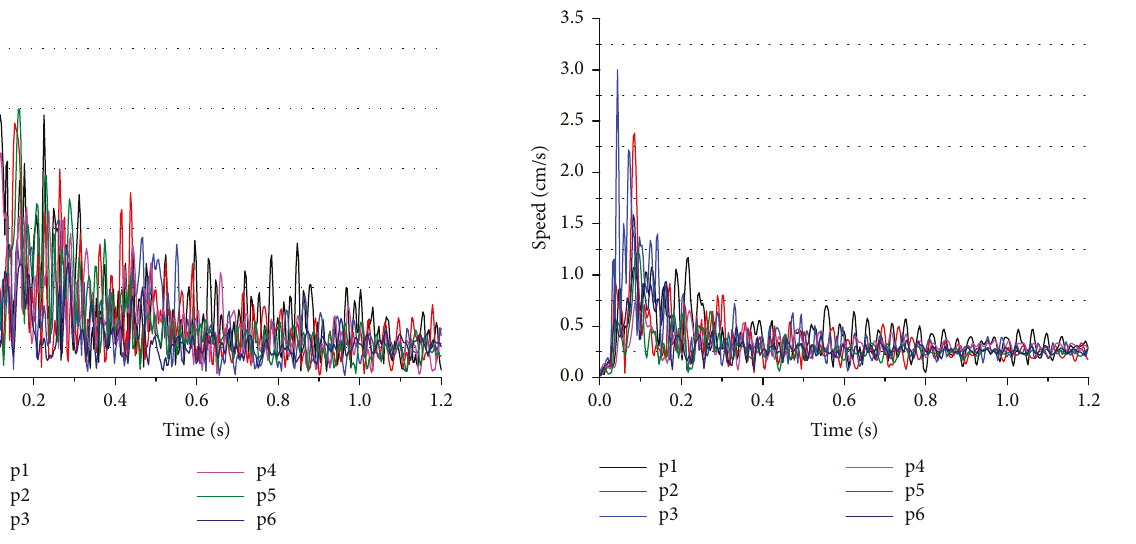
Figure 30: Time-history response curve of velocity at characteristic points on the embankment in the fi rst excavation.